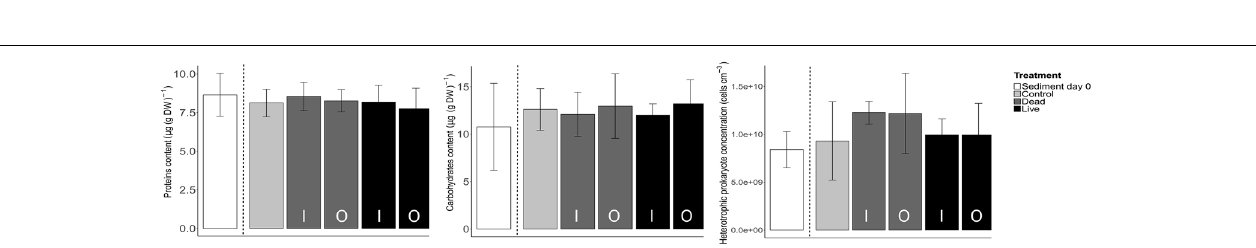
FIGURE 6 | Comparison of concentrations of proteins, carbohydrates and abundance of heterotrophic prokaryotes between treatments. Shown are averages and SD of four samples collected at days 0 and 10 from the inner (I) and outer (O) bed sediment for the dead and live treatments.